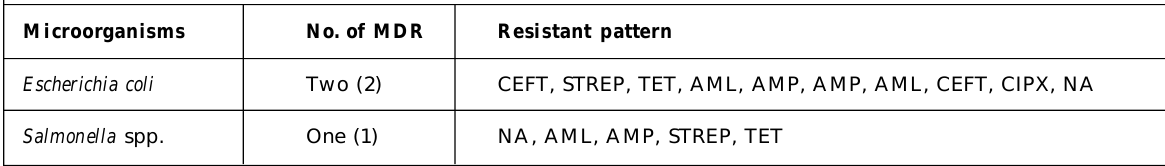
Table 6: Multidrug resistant profile of bacteria isolates Microorganisms No. of MDR Resistant pattern Escherichia coli Two (2) CEFT, STREP, TET, AML, AMP, AMP, AML, CEFT, CIPX, NA Salmonella spp. One (1)